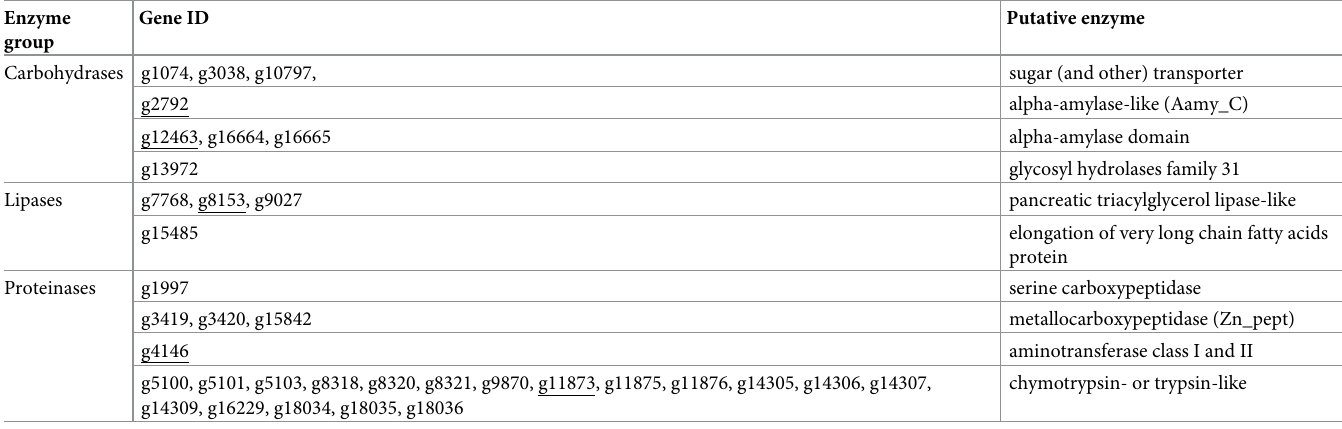
Table 4. Candidate genes putatively involved in digestion identified in the transcriptome of A . compressa adult wasps. Enzyme Gene ID Putative enzyme group Carbohydrases g1074, g3038,